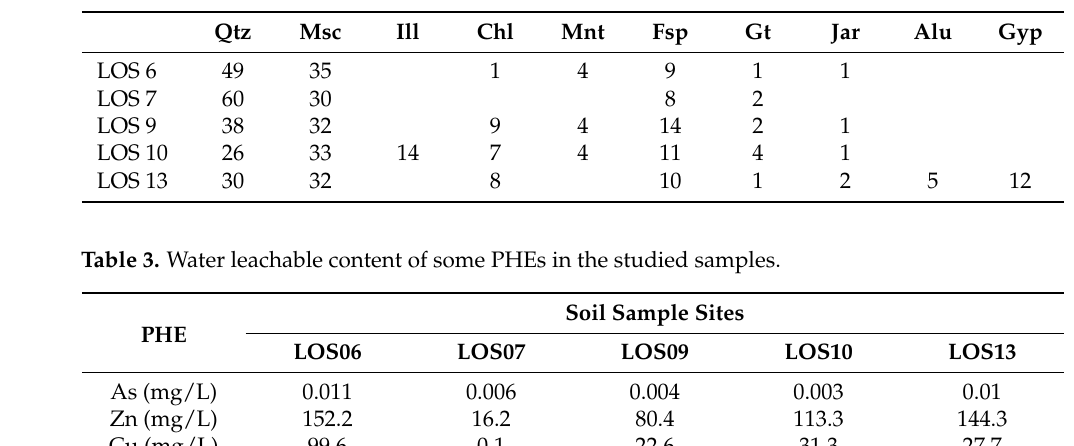
Table 2. Mineralogical composition (wt%) of the studied surficial samples. Qtz: quartz; Msc: muscovite; Ill: illite; Chl: chlorite; Mnt: montmorillonite; Fsp: feldspars; Gt: goethite; Jar: jarosite; Alu: alunite; Gyp: gypsum. Qtz Msc Ill Chl Mnt